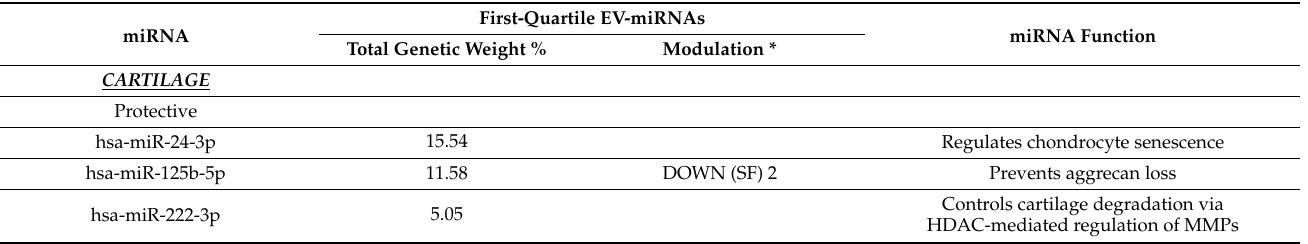
Table 3. miRNAs involved in OA pathological state at cartilage, synovium, and macrophage levels.